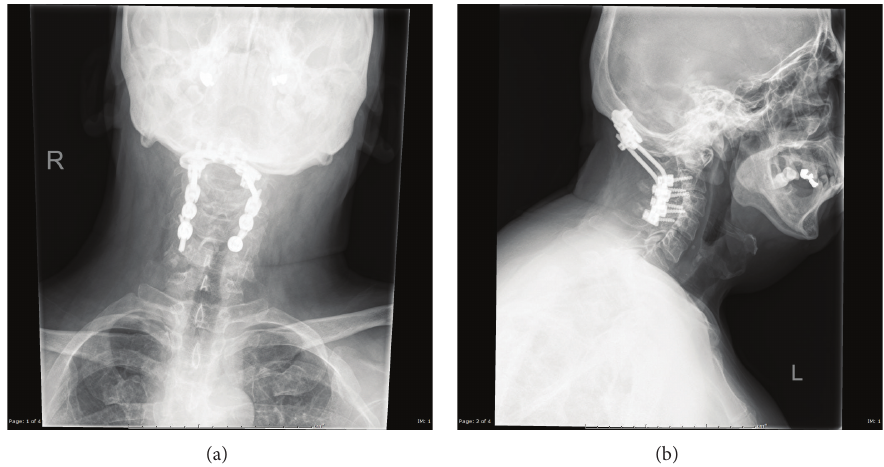
Figure 9: AP (a) and lateral (b) X-rays depicting an occipitocervical